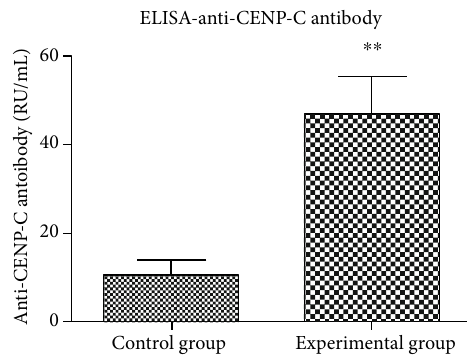
Figure 1: CENP-C antibody development in mouse serum. Concentration of the serum anti-CENP-C antibody in mice between the control group and the experimental group. ∗ P < 0 : 05 , ∗∗ P < 0 : 01